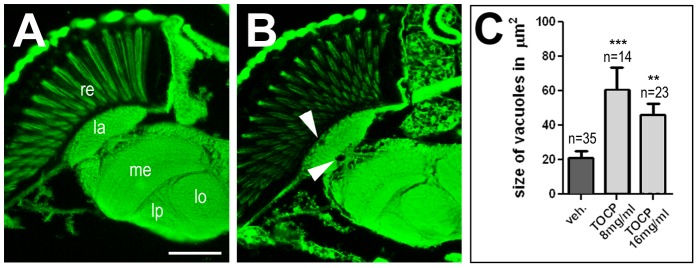
TOCP treated flies show neuronal degeneration.
A. A paraffin head section of a wild type fly 14 d after vehicle treatment does not show overt degeneration. B. In contrast, a few vacuoles (arrowheads) have formed in an age-matched fly treated with 16 mg/ml TOCP. C. Measuring the area of vacuoles in the brain revealed a significant increase in 14 d old flies treated with 8 mg/ml or 16 mg/ml TOCP. Analysis was done using one-way ANOVA with a Dunett's post test to compare to vehicle treated flies. SEMs are indicated, n = number of flies analyzed; **p<0.01, ***p<0.001. Scale bar in B = 2 µm. re = retina, la = lamina, me = medulla, lo = lobila, lp = lobula plate. Scale bar in A = 40 µm. (The variance was not significantly different).